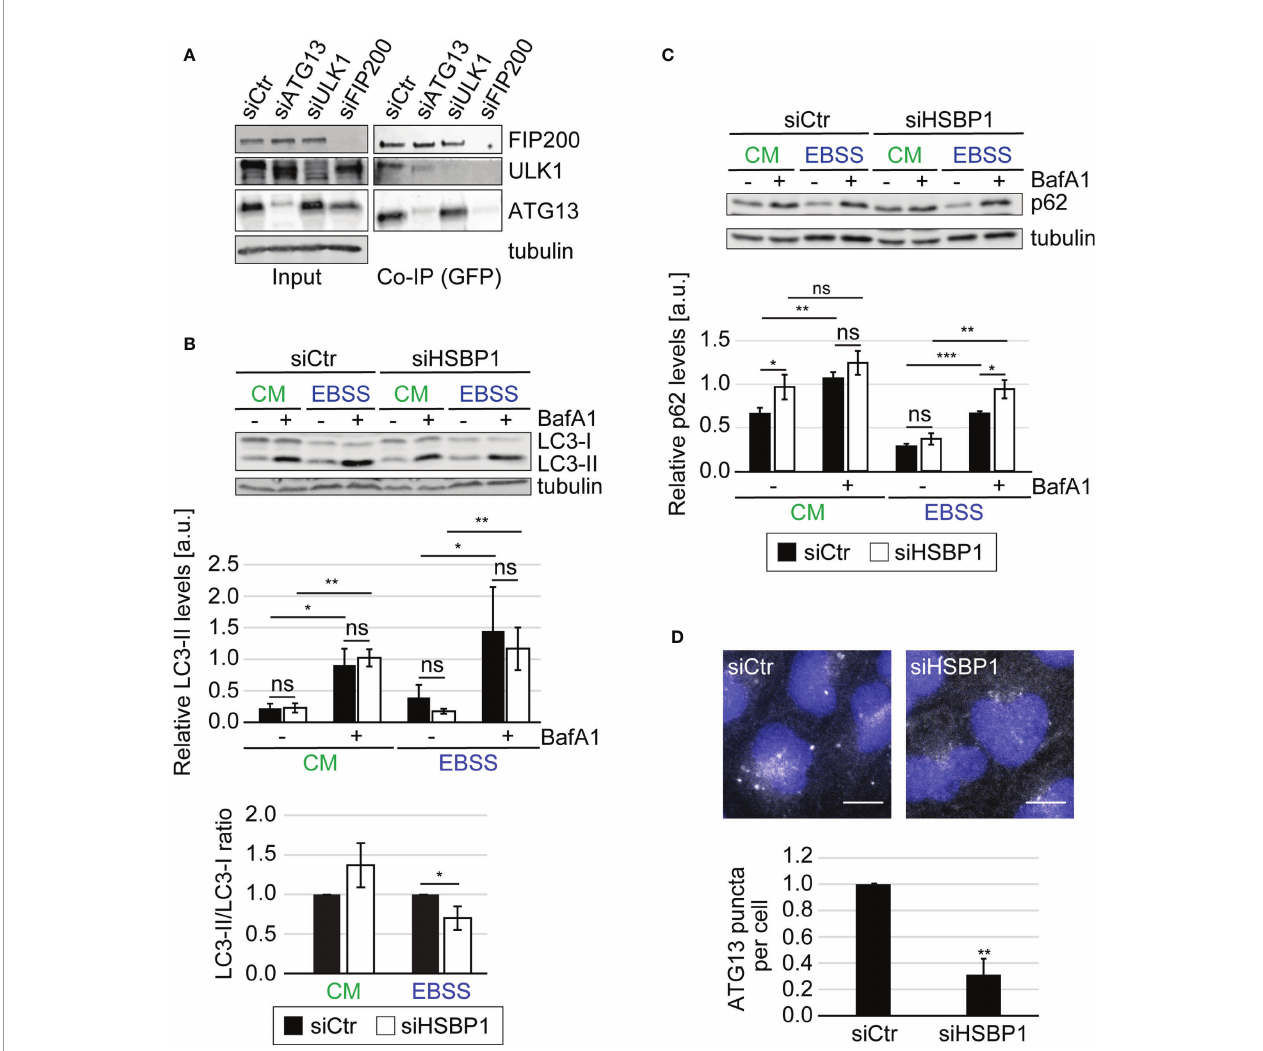
FIGURE 1 | HSBP1 interacts with the ULK kinase complex. (A) GFP-HSBP1 U2OS cells were transfected with control siRNA (siCtr) or siRNAs against ATG13 (siATG13), ULK1 (siULK1) or FIP200 (siFIP200), lysed and subjected to co-immunoprecipitation using GFP ‐ trap beads 48 h after siRNA transfection. Input lysates and Co-IP were examined by WB using antibodies against ATG13, ULK1, FIP200 and tubulin. Tubulin served as the loading control. One representative blot is shown (n = 3). (B, C) U2OS cells were transfected with either siCtr or siHSBP1 for 48 h and then maintained in the control medium (CM) or transferred into EBSS to induce autophagy, in the presence (+) or the absence (-) of 200 nM BafA1 for 2 h. Cells were then lysed and proteins examined by WB using anti-LC3 (B) , anti-p62 (C) and anti-tubulin antibodies. Tubulin served as the loading control. LC3-II and p62 signals were normalized to tubulin (a.u., arbitrary units) and LC3-II/LC3-I ratios determined, and values are presented in the depicted graphs. Error bars represent the standard deviations (SDs) of 3 independent experiments. (D) U2OS cells were transfected with either siCtr or siHSBP1 for 48 h and then transferred into EBSS medium for 2 h, before being processed for IF using anti-ATG13 antibodies. Representative images are shown and the number of ATG13-positive puncta per cells was quanti fi ed. Error bars represent SDs of 3 independent experiments. Scale bars: 10 µm. The statistical signi fi cances were calculated to the controls. The symbols *, ** and *** indicate signi fi cant differences of p < 0.05, p < 0.01 and p < 0.001, respectively and ns indicate not signi fi